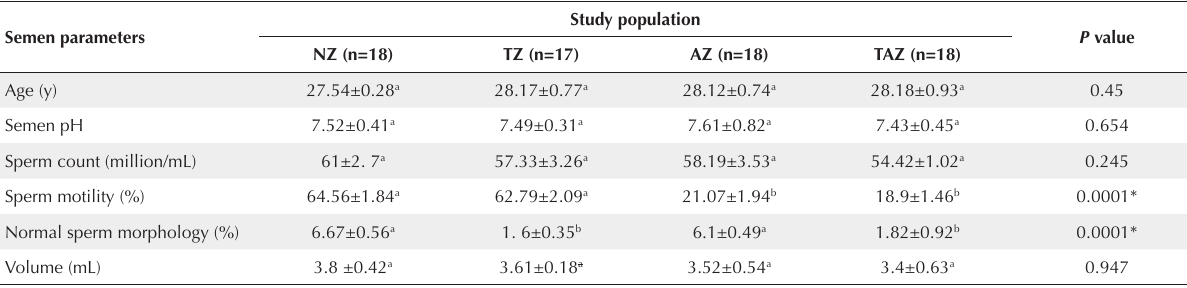
Table 1. Semen Analysis Results of the Studied Patients Semen parameters